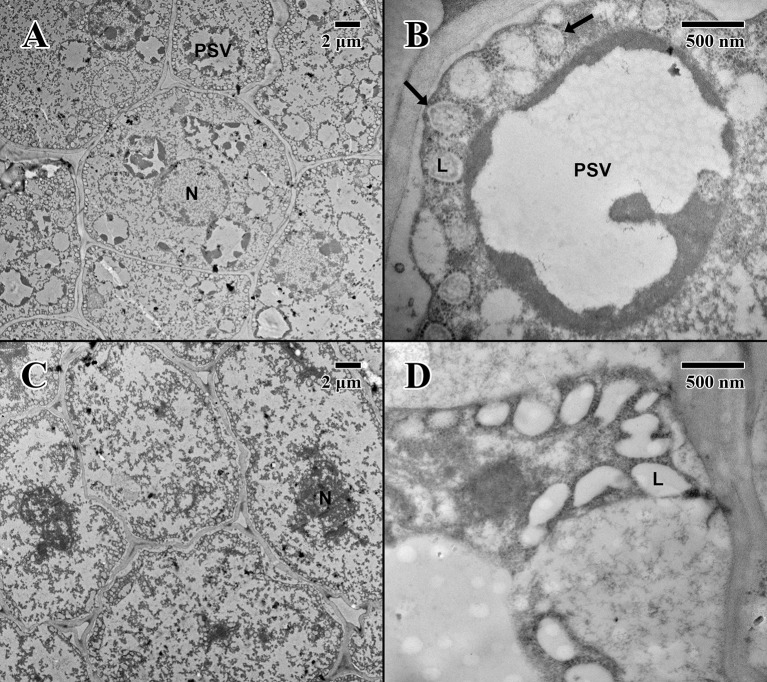
Transmission electron microscope micrographs of cotyledon parenchyma of date palm embryos in the imbibed state. (A) ×1,000 2004 embryo (MSB accession no. 211945). Scale bar = 2 μm. (B) ×10,000 2004 embryo (MSB accession no. 211945). Scale bar = 500 nm. (C) ×1,000 1873 embryo (EBC accession no. 36011). Scale bar = 2 μm. (D) ×10,000 1873 embryo (EBC accession no. 36011). Scale bar = 500 nm. (N, nucleus; L, lipid body; PSV, protein storage vacuole; arrows = explained in text.)